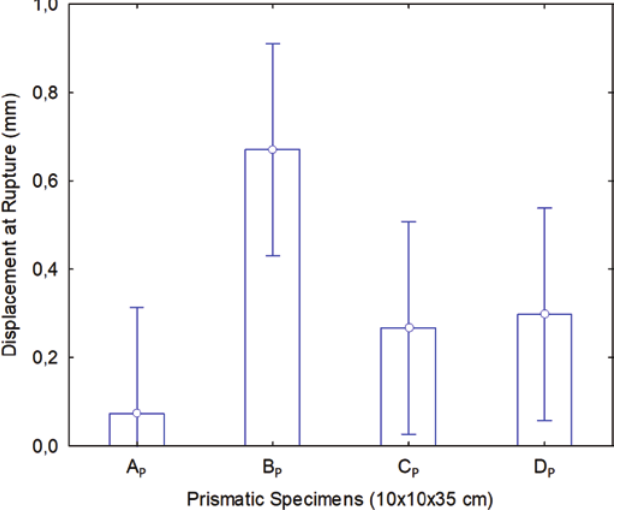
Analysis of the results of displacement at rupture in prismatic specimens (10 × 10 × 35 cm)